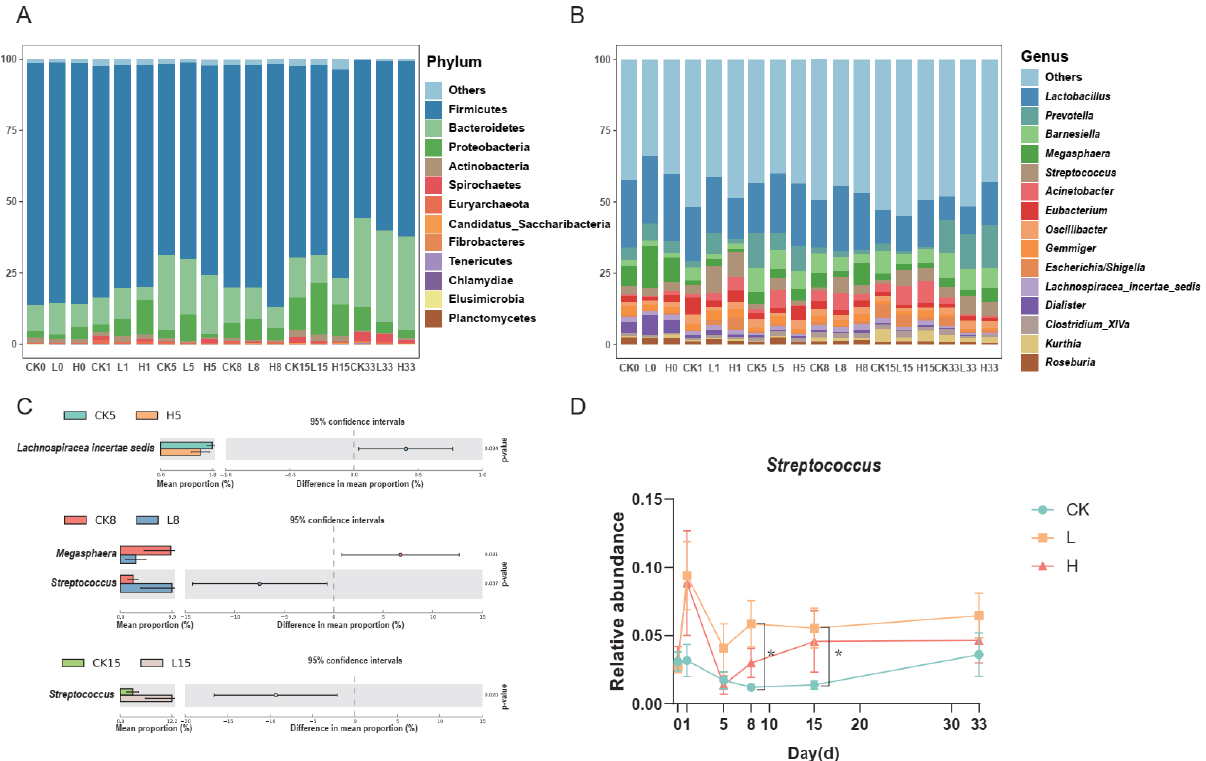
Figure 3. The bacterial community structure at the phylum level ( A ) and genus level ( B ) in pig feces. ( A ) The relative abundance of 12 phyla was 98.22%. ( B ) The top 15 genera accounted for 54.12% of the total relative abundance; there were 11 bacteria belonging to Firmicutes, including Lactobacillus , Megasphaera , Streptococcus , Eubacterium , Oscillibacter , Gemmiger , Lachnospiracea_incertae_sedis , Dialister , Clostridium_XlVa , Kurthia and Roseburia. Prevotella and Barnesiella which belong to Bacteroidetes, and the remaining Acinetobacter and Escherichia/Shigella belong to Proteobacteria. ( C ) The bacteria in the treatment groups were significantly different from those in the group CK and belonged to the top 15 genera. ( D ) Line chart of the relative abundance of Streptococcus over time (* represents p < 0.05).